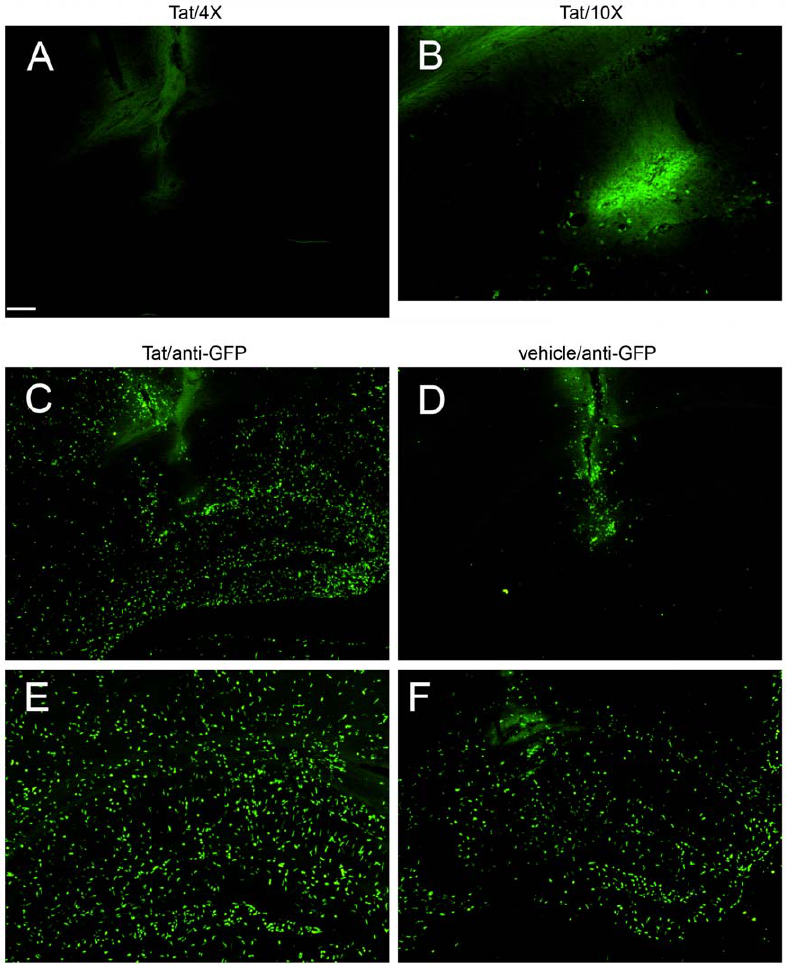
Figure 2. Stereotactic injection of Tat induces a differential effect on infiltrating inflammatory leukocytes depending on gene dose of CX3CR1. Montage of microscopic fields 24 hours after Tat (Panels A–C, E) or control vehicle (Panels D, F) injection into the right hippocampus of irradiation chimeras. Images in Panels A, B, C, and D were taken from CD45.1 host mice engrafted with heterozygous CX 3 CR1/GFP + / 2 bone marrow, whereas images E and F were from CD45.1 host mice engrafted with homozygous CX 3 CR1/GFP + / + bone marrow. A, C, D, E, and F were taken with a 4 6 objective with the same 0.9 sec exposure time and B was taken with a 10 6 objective with a longer exposure time (4 sec) to intensify the weak fluorescence of the GFP signal. Panel A and B depict very low expression of fluorescence from infiltrating GFP expressing leukocytes, while Panels C–F depict amplified GFP expression with anti-GFP antibody and Alexa 488 conjugated second antibody treatment. All experimental and control groups, n=3 independent replicates. Scale bar=100 m m for Panels A, C, D, E, and F; 40 m m for